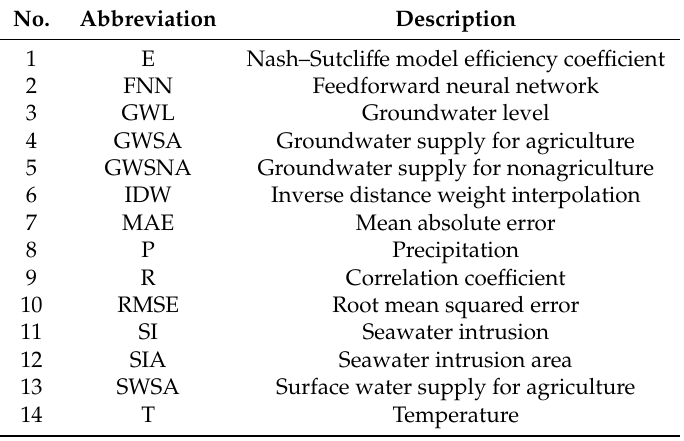
Table A1. The description of abbreviations in the